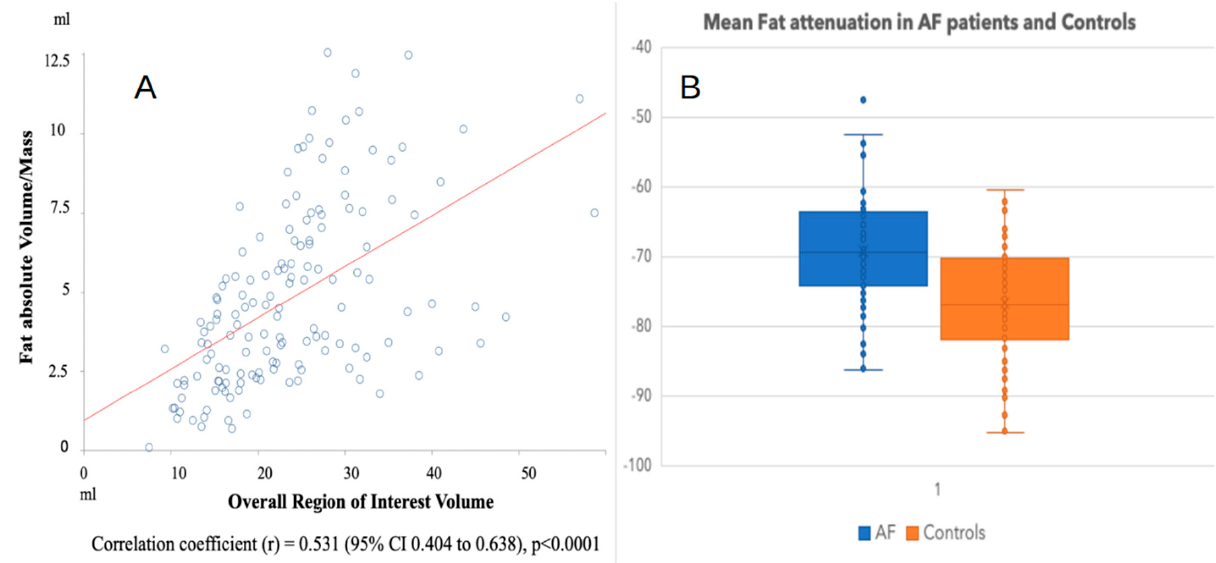
Figure 2. ( A ) The absolute volume of adipose tissue detected that was located posterior to the left atrium was significantly and directly correlated (simple linear regression) with the size of the region of interest sampled. ( B ). Mean adipose tissue (located posterior to the left atrium) attenuation in patients with atrial fibrillation and controls.